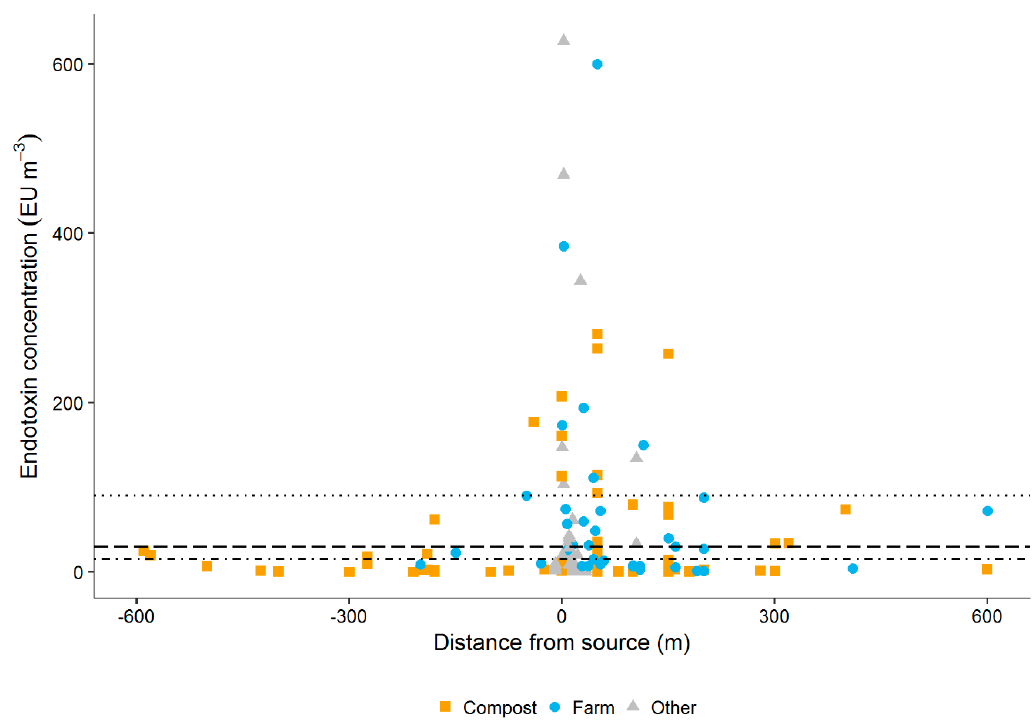
Figure 2. Mean concentrations of endotoxins as a function of distance from the source as reported in the literature. A negative value indicates samples taken downwind of the source (0 m), whilst positive values indicate upwind samples. The dashed and dotted lines represent the proposed 30 EU m − 3 limit and a no-observed-effect level (NOEL) of 90 EU m − 3 , respectively. The dot-dashed line indicates the 95th percentile of mean upwind concentrations, excluding three points with very high concentrations likely influenced by other endotoxin sources (full dataset available in the Supplementary